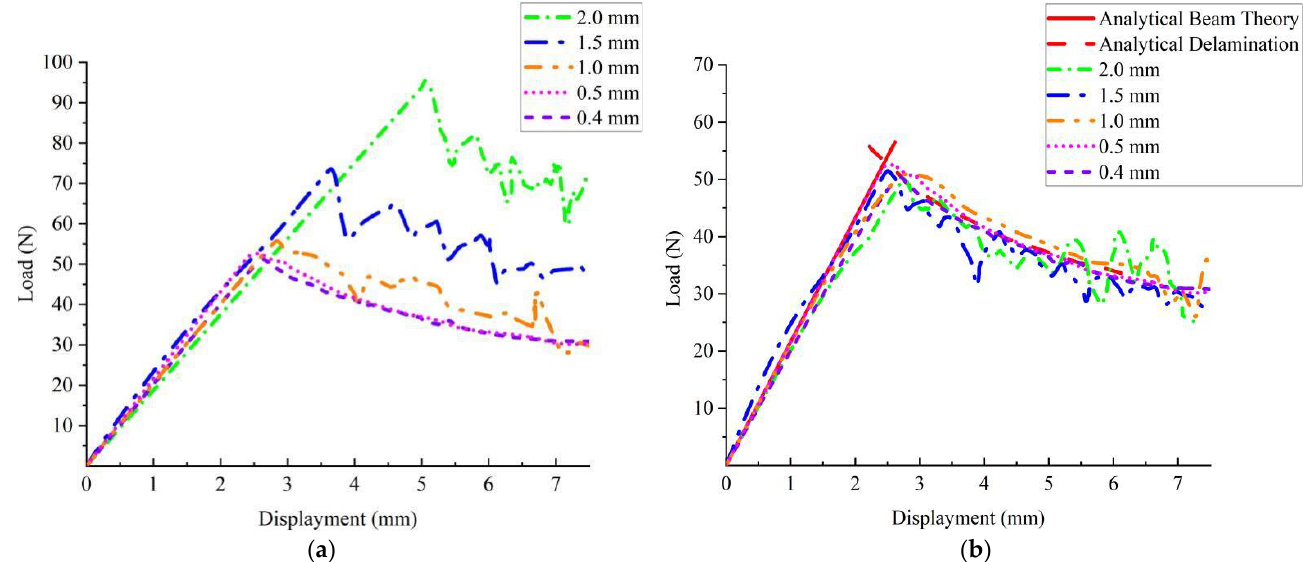
Figure 6. Model I delamination failure based on the tiebreak contact algorithm correction. ( a ) Uncorrected load–displacement curve; ( b ) corrected load–displacement